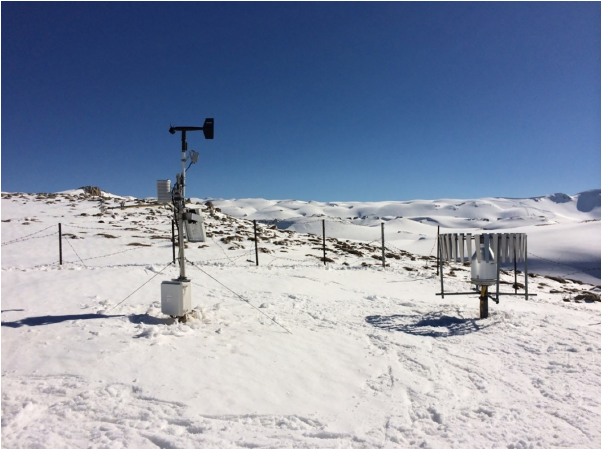
Figure 3. Automatic weather station at Mzar (MZA) (2296ma.s.l.) where all sensors are located on the tower and the precipitation gauge is located to the right of the station. Image captured on 5 March 2015 (courtesy of the